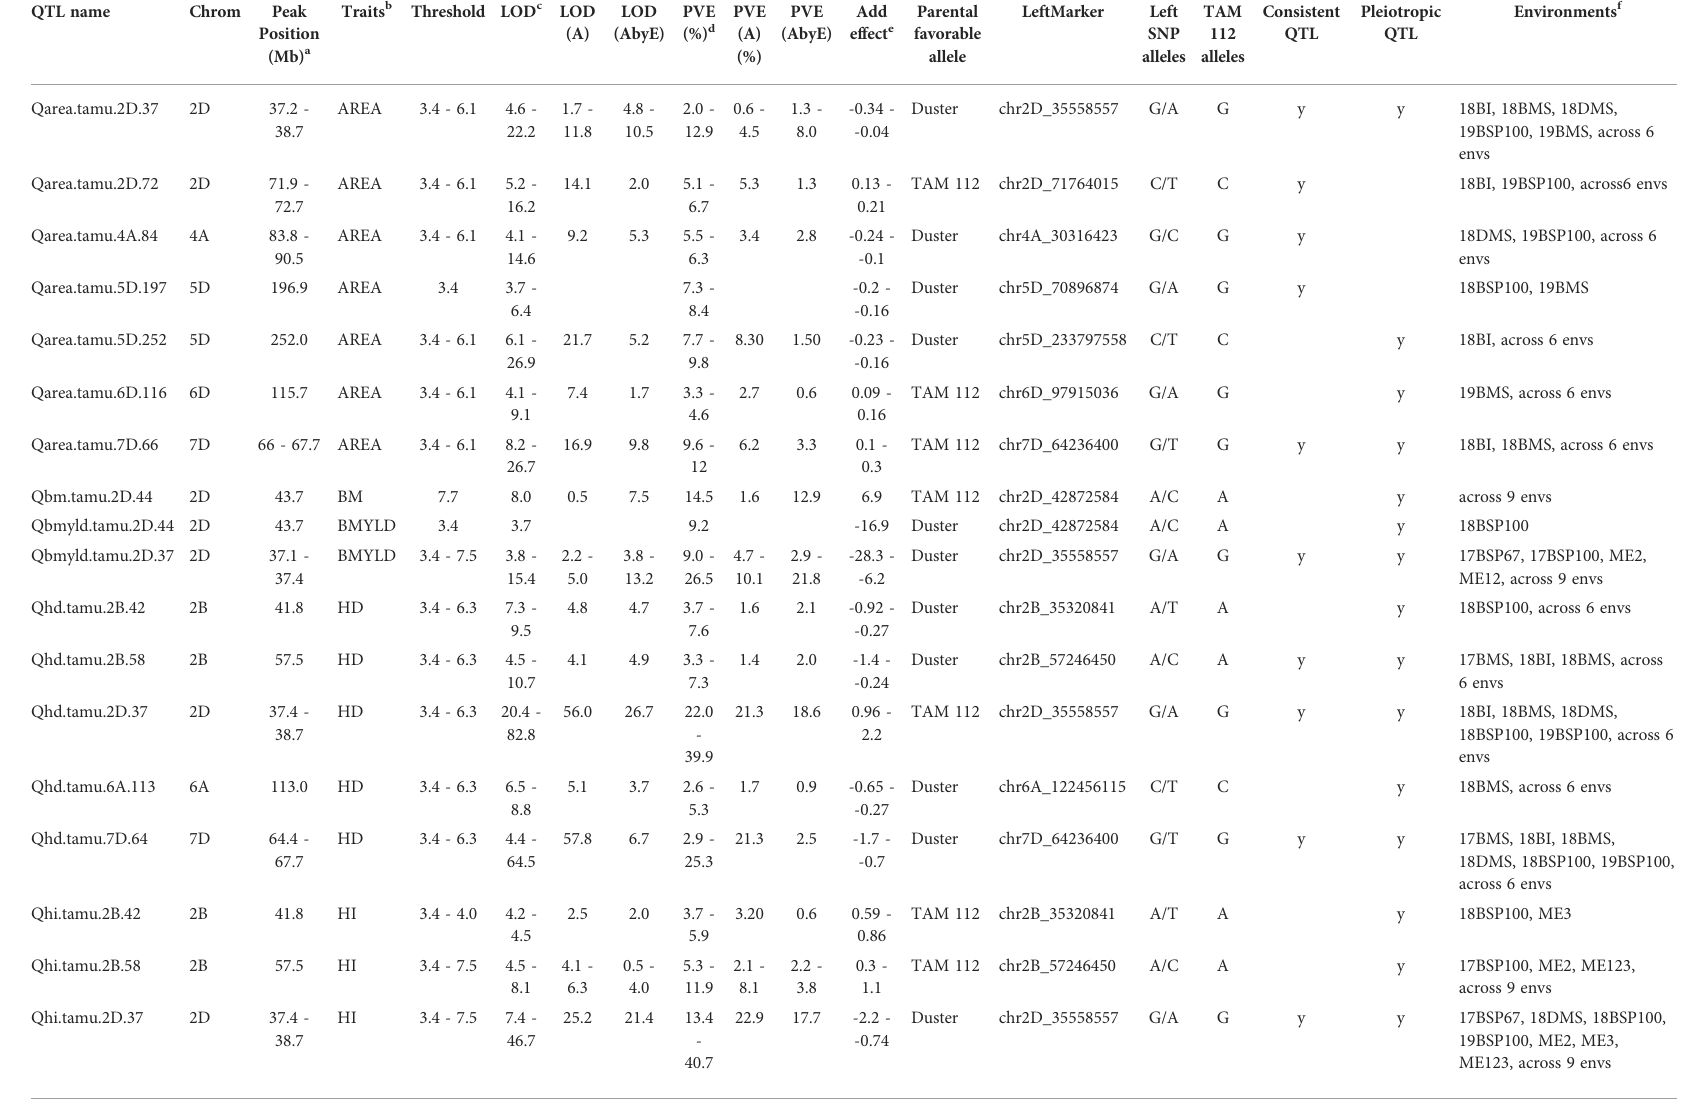
LeftMarker Left TAM Consistent Pleiotropic Environments f SNP 112 QTL QTL allele alleles alleles